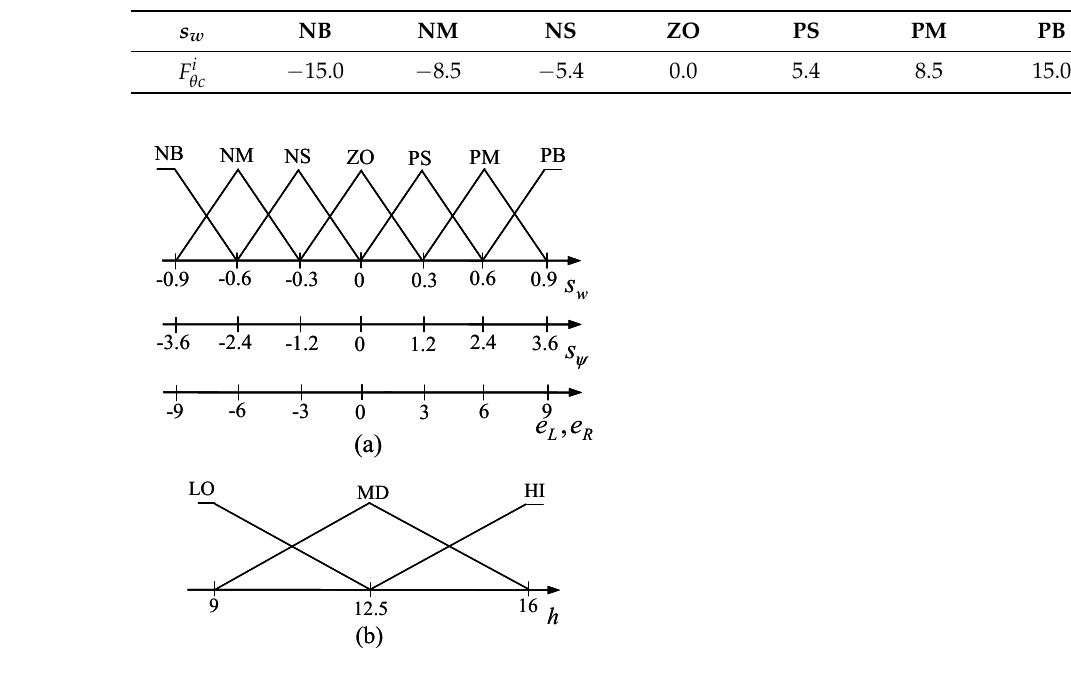
Figure 5. Membership functions. ( a ) FMBC and FRBC; ( b ) FYSC.